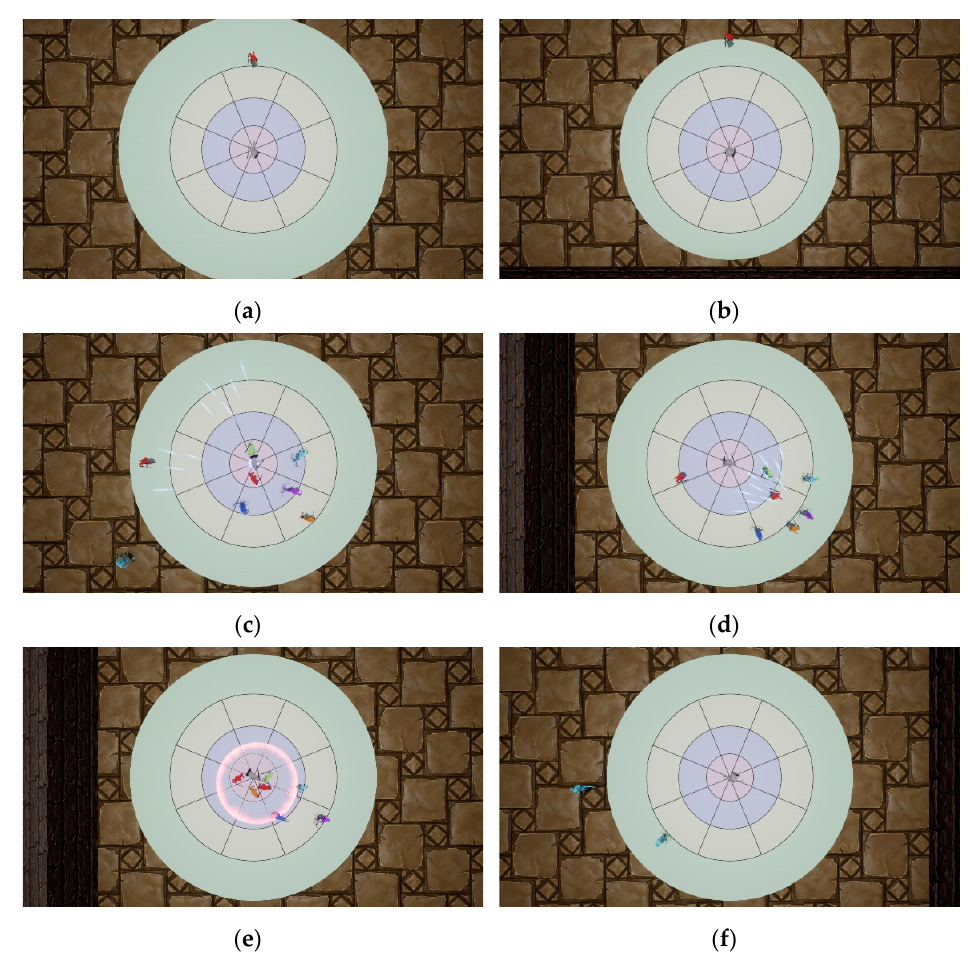
Figure 11. Tests for the execution process of RID algorithm of IBAI. ( a ) The first combat scene; ( b ) The second combat scene; ( c ) The third combat scene; ( d ) The fourth combat scene; ( e ) The fifth combat scene; ( f ) The sixth combat scene.